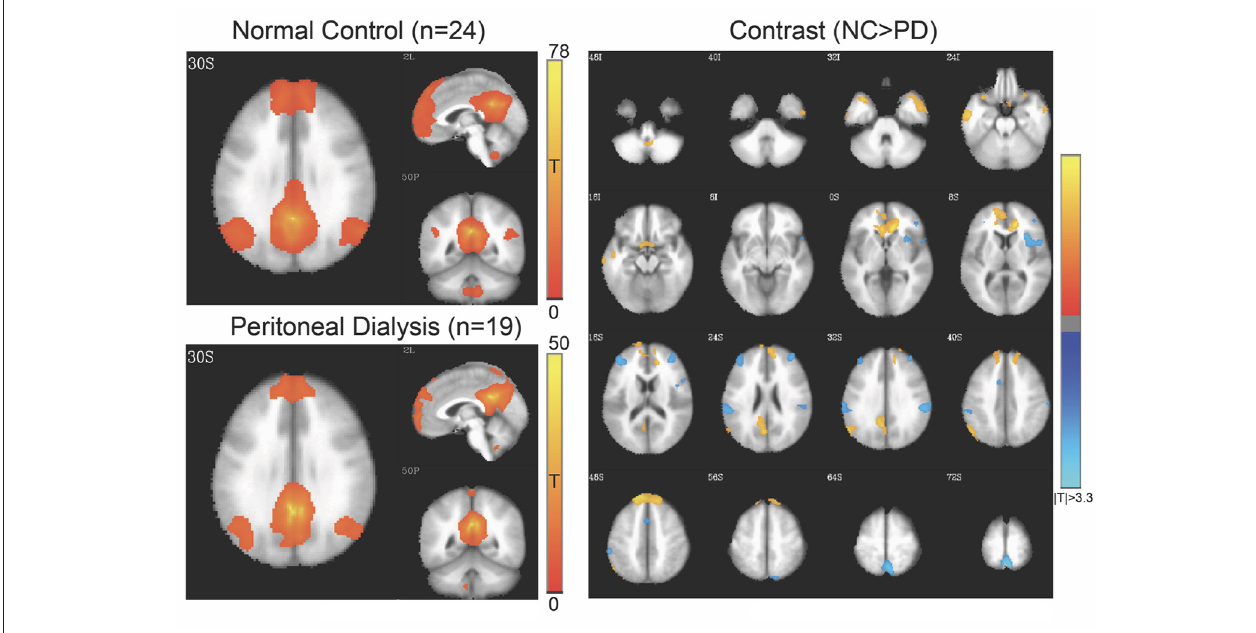
FIGURE 2 | Default-mode network (DMN) of controls and patients with PD. Connectivity map of either group is shown at left side (FWE-corrected p < 0.05), and the contrast at right side (3dClustSim-corrected p < 0.05). In the contrast map, the orange color represents significantly increased connectivity in controls, including anterior cingulate gyrus, superior and medial frontal gyrus, temporal lobe, and precuneus, whereas the blue color represents decreased connectivity in controls, including the insula, inferior parietal lobule, middle frontal gyrus, and supplemental motor area. PD, peritoneal dialysis; NC, normal controls.